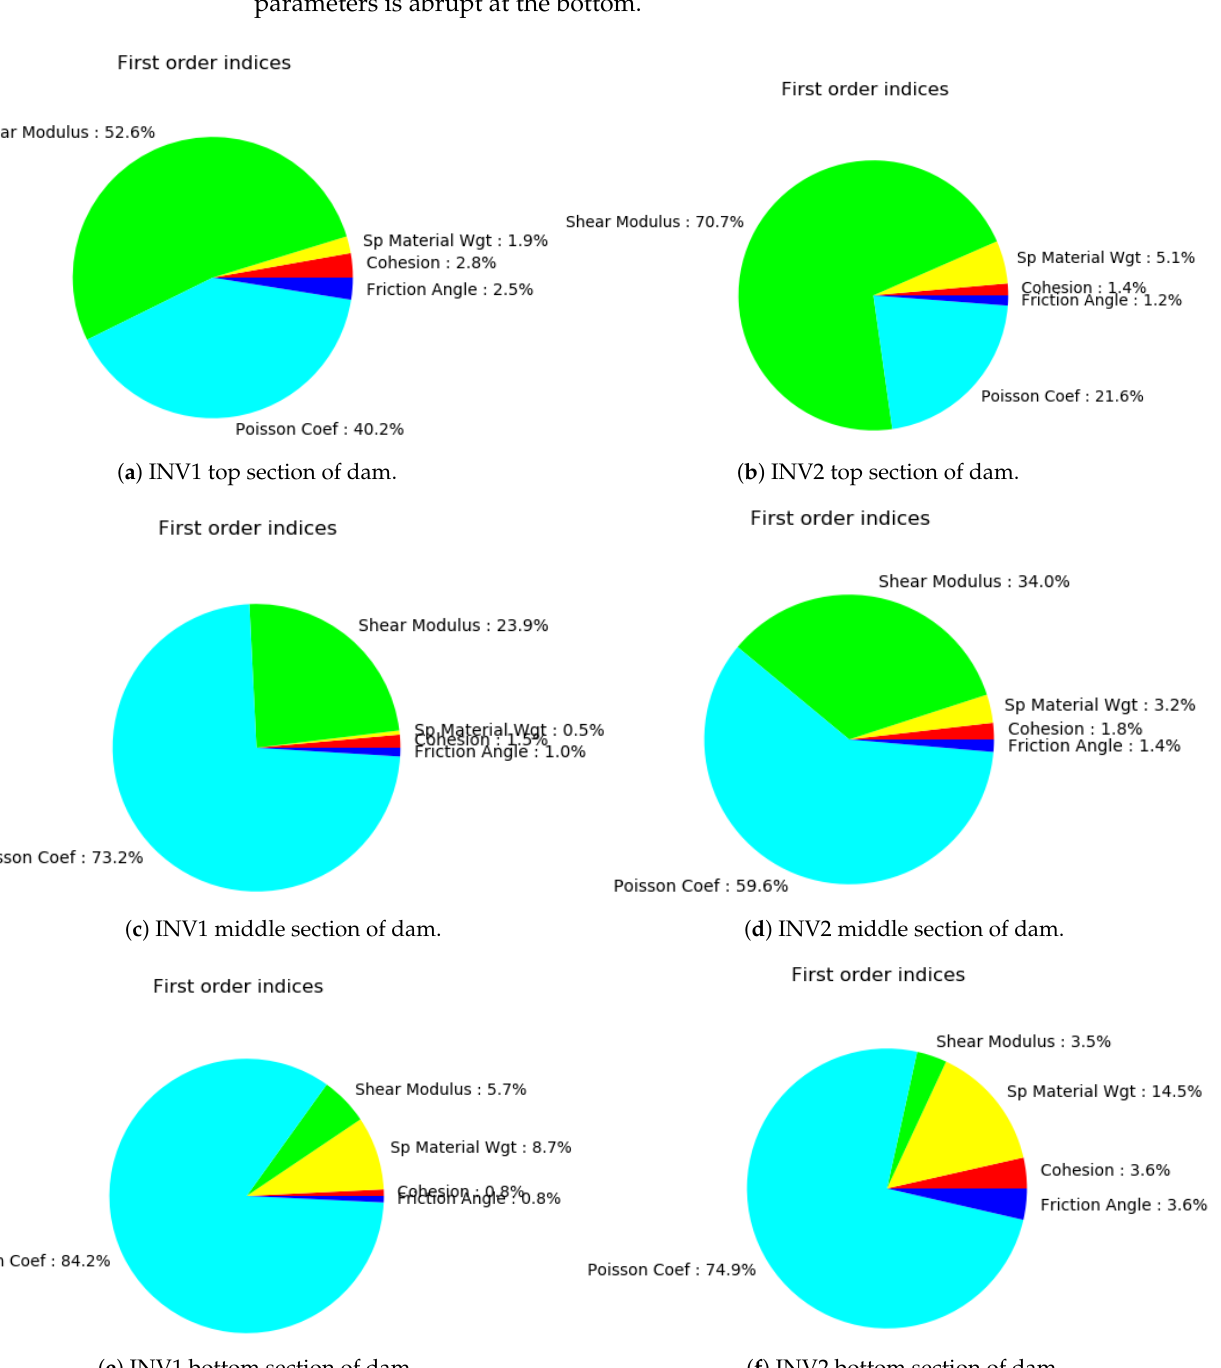
Figure 6. The pie charts show the sensitivity indices for INV1 and INV2 vertical displacements,